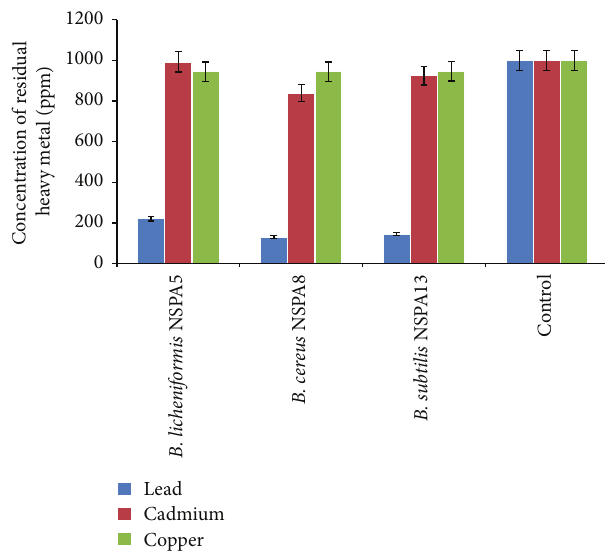
Figure 2: Metal concentration in the medium determined by AAS after removal of the